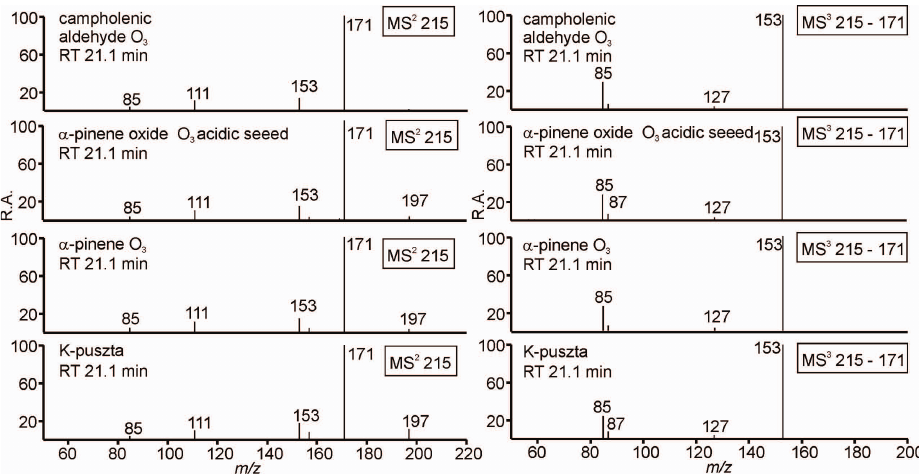
Fig. 10. MS 2 and MS 3 product ion spectra for the m / z 215